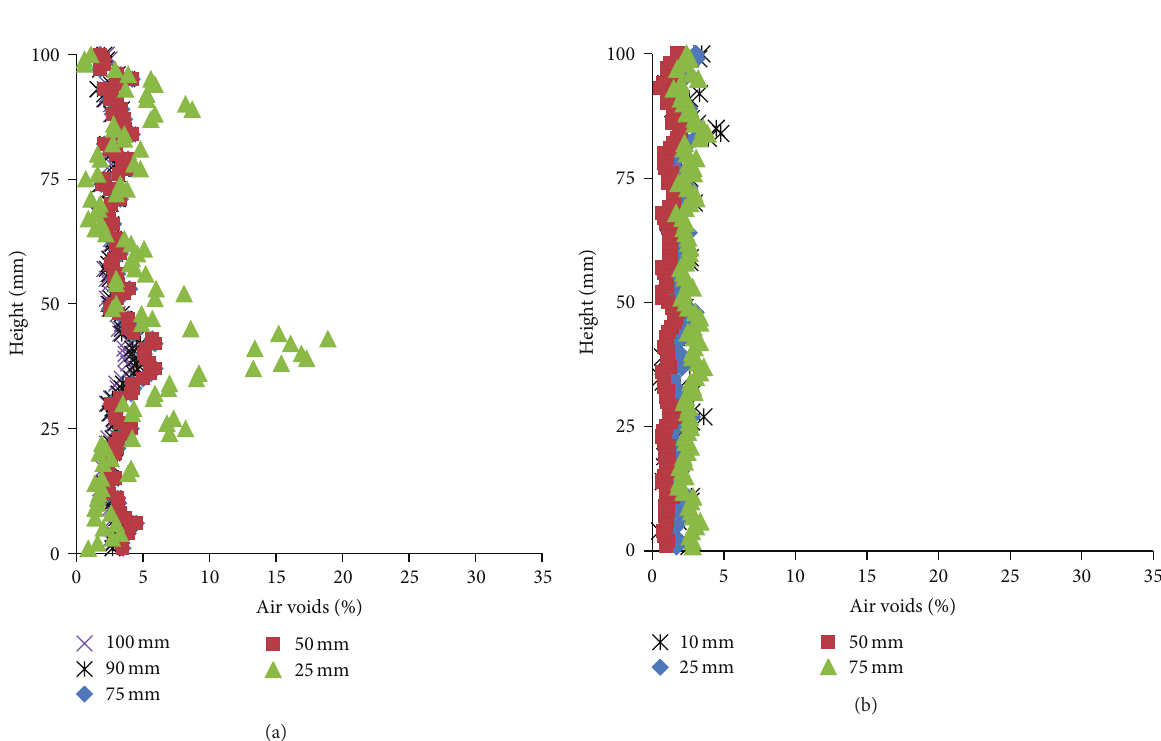
Figure 12: Air voids distribution within the virtual cut of (a) core and (b) ring for RA-Mix with the air voids content of 2.6% and density of 2420 kg/m 3